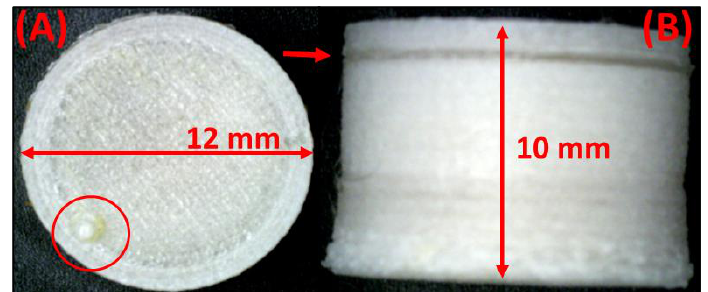
Figure 8. Tablet images captured using an optical microscope: ( A ) top-view of a tablet with 1 mm wall diameter and ( B ) side-view of the tablet with 1 mm wall diameter.